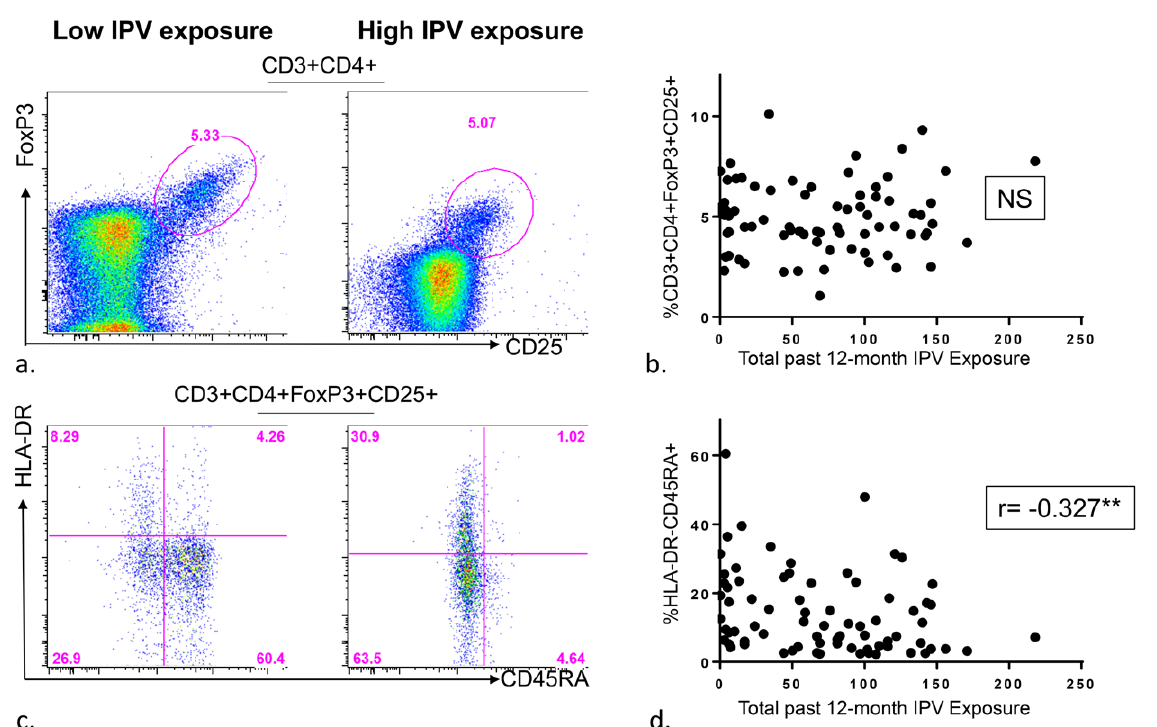
Figure 4. Association between past-year intimate partner violence (IPV) experience and regulatory (CD4 + Foxp3 + CD25 + ) T-cell frequency and phenotype among HIV high-risk women. (A) Representative flow diagrams demonstrating frequencies of regulatory (CD4 + Foxp3 + CD25 + ) T-cells in the PBMC of two donors with low versus high reporting of past-year IPV experience. (B) Summary data from 75 HIV high- risk women demonstrating past-year IPV experience was not significantly associated with frequency of regulatory (CD4 + FoxP3 + CD25 + ) T-cells in PBMC. (C) Representative flow diagrams depicting frequencies of regulatory (CD4 + FoxP3 + CD25 + ) T-cell phenotypes using CD45RA and HLA-DR markers in the PBMC of two donors with low versus high reporting of past-year IPV experience. (D) Summary data from 75 HIV high-risk women demonstrating past-year IPV experience is negatively associated with the frequency of naïve regulatory T-cells (HLA-DR - CD45RA + CD4 + FoxP3 + CD25 + ) in